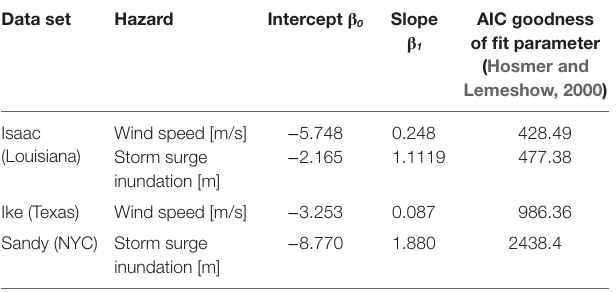
TaBle 5 | Logistic regression results for selected storms; some results are from Reed et al. (2016).